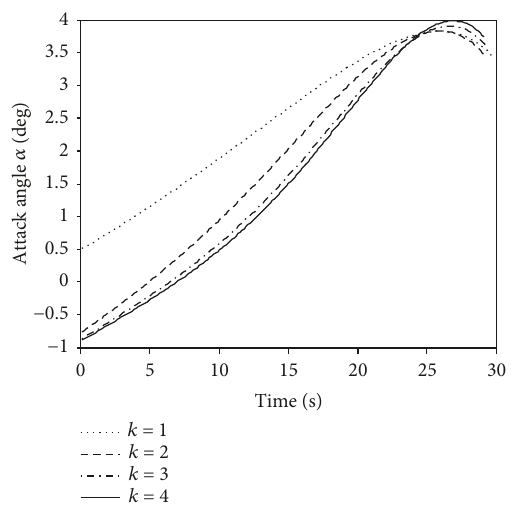
Figure 4: Angle-of-attack pro fi le in the fi rst four successive iterations of the SOCP-based algorithm.